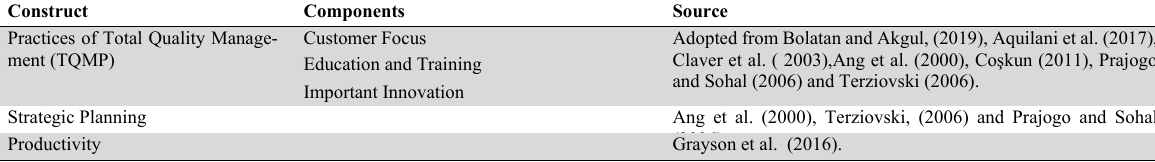
Measurement Constructs Construct